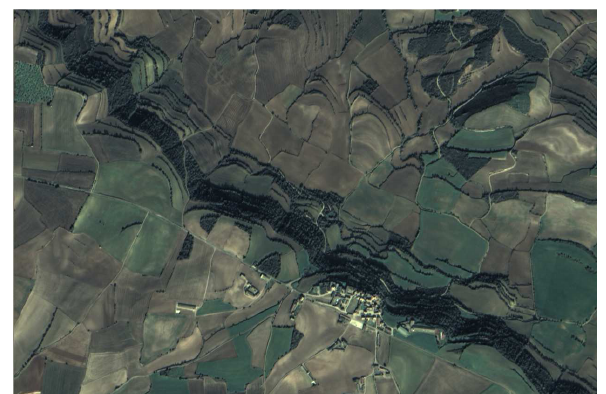
Figure 6. Adaptative IHS fused